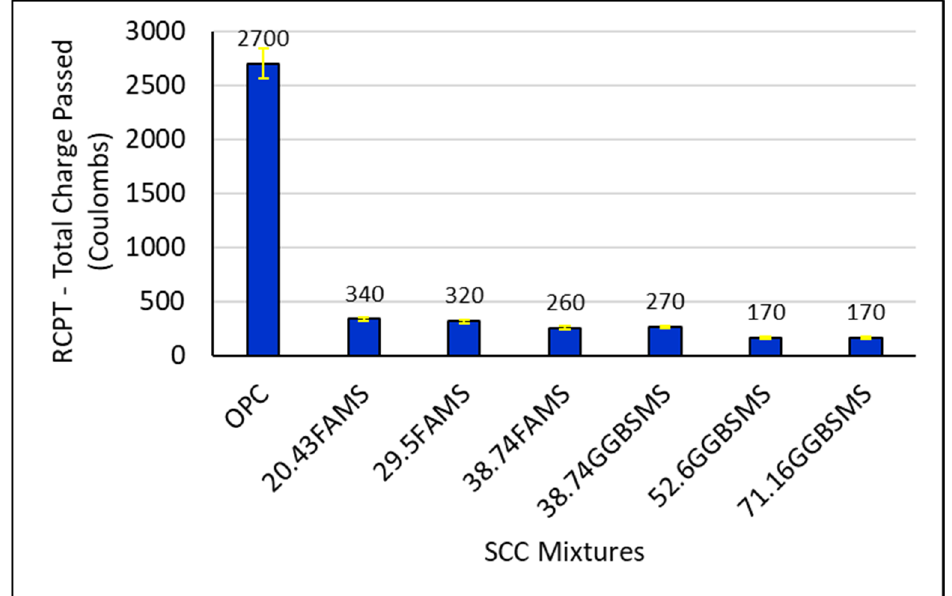
Figure 17. Total charge passed (RCP) of SCC mixtures at 28 days.